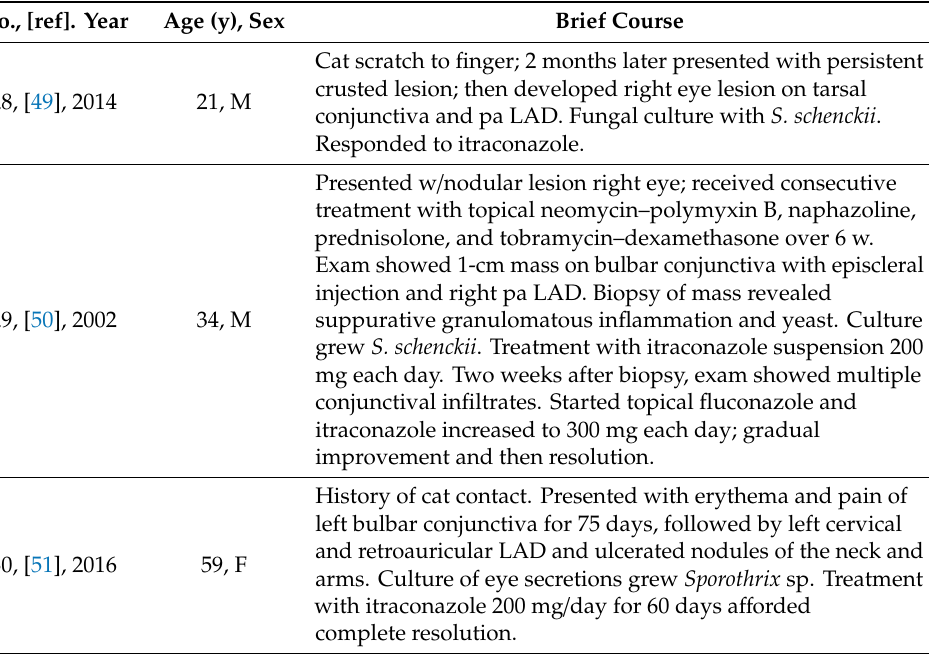
Table 5. Parinaud’s oculoglandular syndrome in Sporothrix